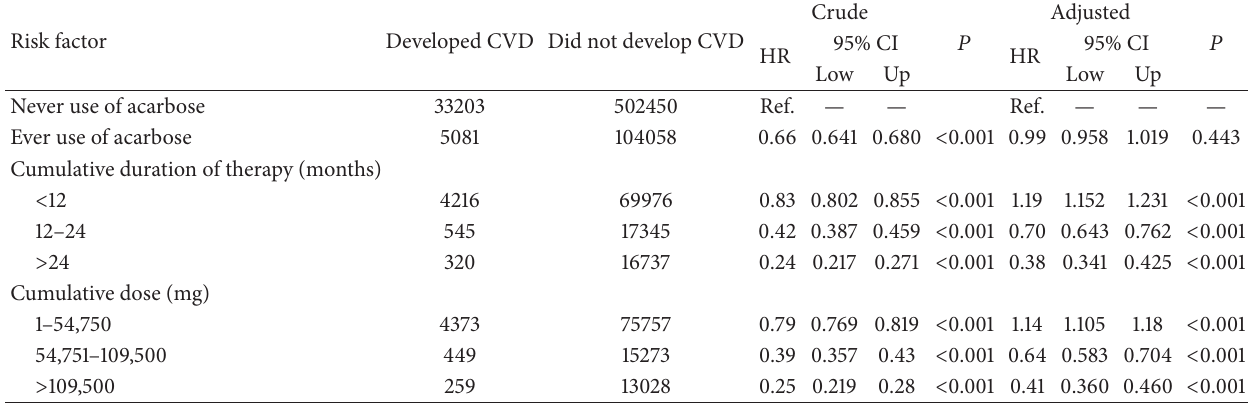
Table 2: Crude and adjusted hazard ratio of CVD with or without acarbose use.